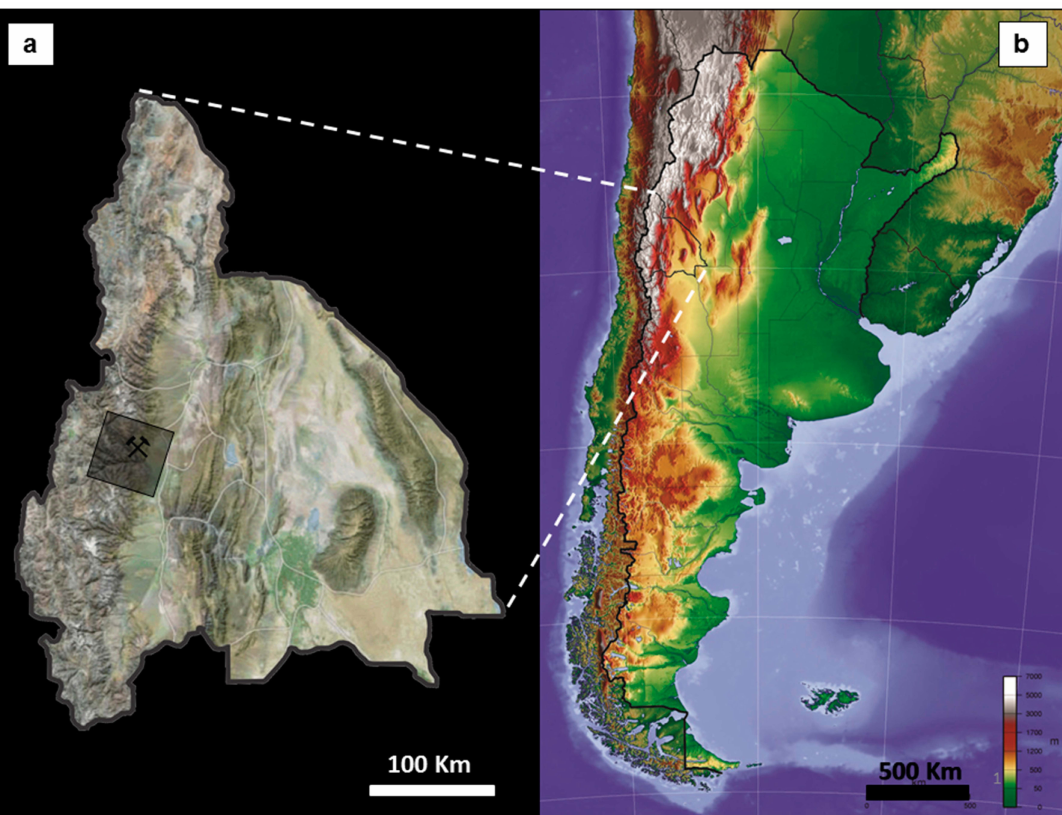
Figure 2. Map of San Juan province ( a ) and Argentina ( b ). The shaded square in Figure 2a represents the area of the ASTER scene used for the current study. The crossed hammers symbol indicates the location of the San Francisco de los Andes